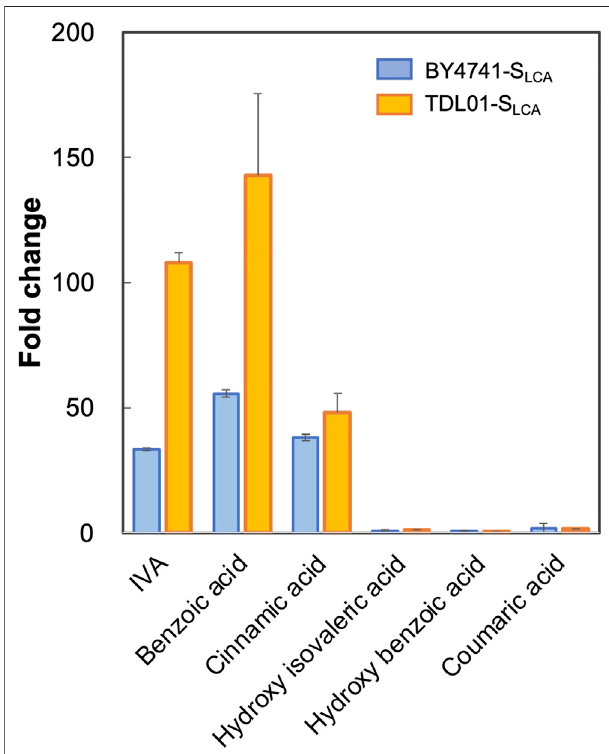
FIGURE 3 | Responses of biosensor TDL01-S LCA with PDR12 gene deletion to representative weak organic acid including IVA, benzoic acid, cinnamic acid, hydroxy isovaleric acid, hydroxy benzoic acid and coumaric acid. BY4741-S LCA and TDL01-S LCA cells were grown until the exponential phase. After a 16-h incubation in a buffered SCD-U medium (at pH6.5) with the supply of weak organic acids (2 mM each), GFP fl uorescence was measured, and fold changes were calculated. Values are means of three independent experiments, and an error bar represents standard deviation of three independent